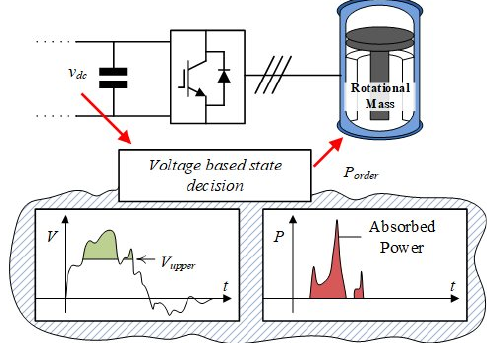
Figure 3. Voltage limitation ‐ based ESS control scheme.